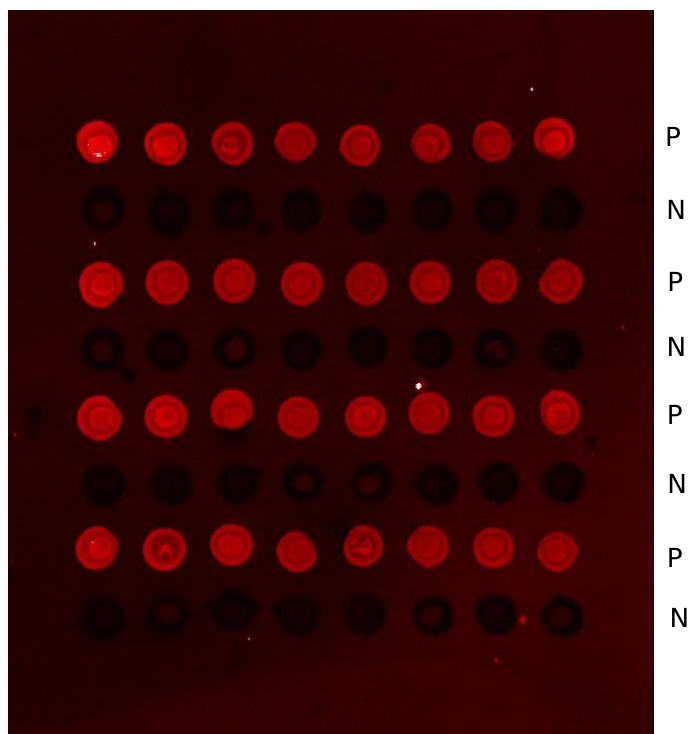
Figure 3. Reliability of the